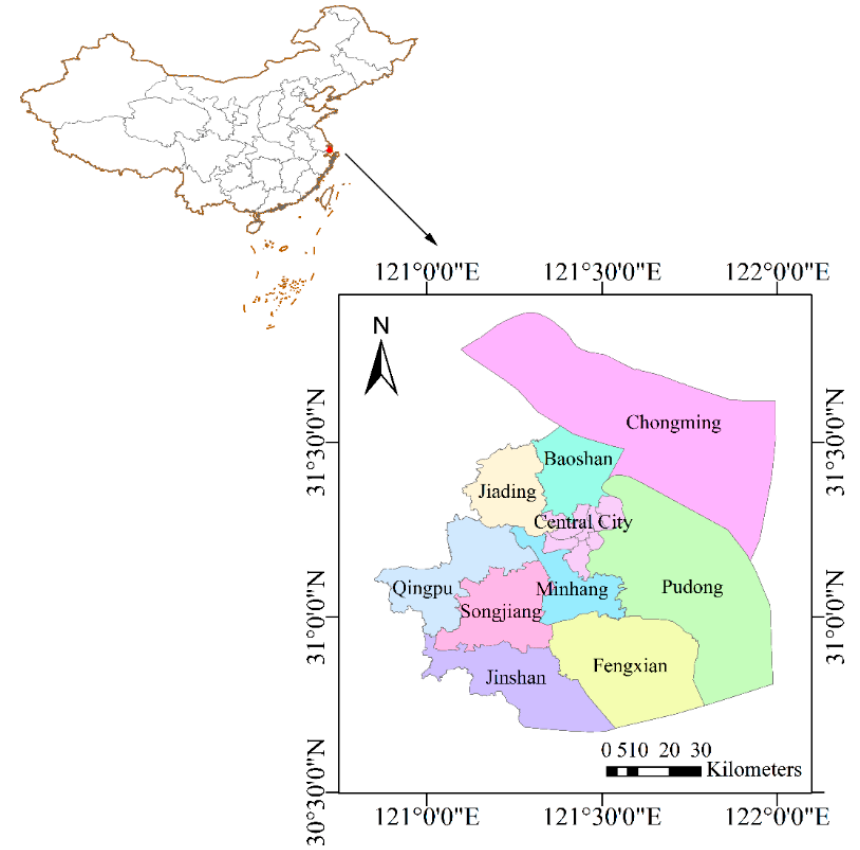
Figure 2. Geographical location and zoning map of Shanghai, China.